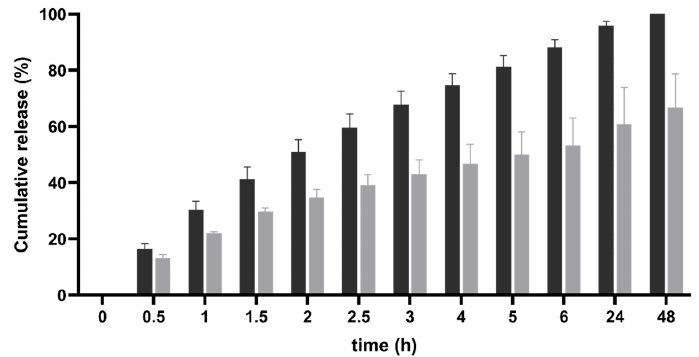
Figure 3. BODIPY release at pH 7.4 and 298 K from micelles made of mPEG–(PLLA) 2 (black) and mPEG–(PLLA) 4 (grey). The different behavior in releasing BODIPY, as showed by the two systems, are both intriguing for a coating that requires a slow release of the antimicrobial PS. However, we decided to test the antimicrobial efficiency of the system based on the more stable micelles that release completely within 48 h. To this aim, the efficiency of BODIPY in photoinactivation of the model strain S. au- reus ATCC 6538P was tested, and data are reported in Figure 4. Under a low energy dose of light (8.7 J/cm 2 ) at 520 nm, BODIPY showed a dose-dependent killing effect. The lowest tested concentration (0.1 μ M) caused a statistically significant reduction ( p = 0.0361) of ~4 log unit, while the highest concentration (1 μ M) caused the highest killing rate detectable in the chosen setup, namely ≤ 100 CFU/mL ( p = 0.0023). All the included controls ruled out any intrinsic activity of BODIPY and of solvent used to solubilize PS (DMSO 0.01%). As expected, green light did not influence S. aureus viability. It is well known that neutral PSs belonging to several families, natural and synthetic, such as curcumin, hypericin, phthal- ocyanine, and fullerenes, are active against Gram-positive bacteria [47]. To the best of our knowledge, in this study, for the first time a neutral BODIPY was successfully tested as a PS against S. aureus. It is noteworthy to point out that the BODIPY was active at low mi- cromolar concentration and was active only under irradiation. These features make the chosen BODIPY an interesting antimicrobial PS.